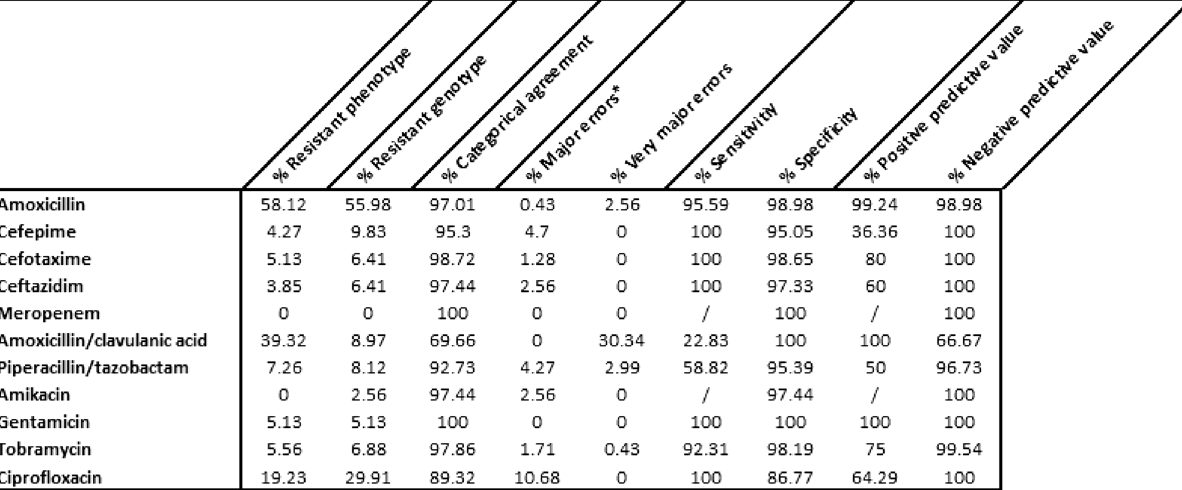
Figure 3. Summary of the results of the 234 analyzed E. coli isolates. Meropenem was excluded due to the lack of resistant isolates. *Of note, 22.73% of the major errors tested phenotypically as ‘susceptible at higher exposure’, and were therefore considered as not